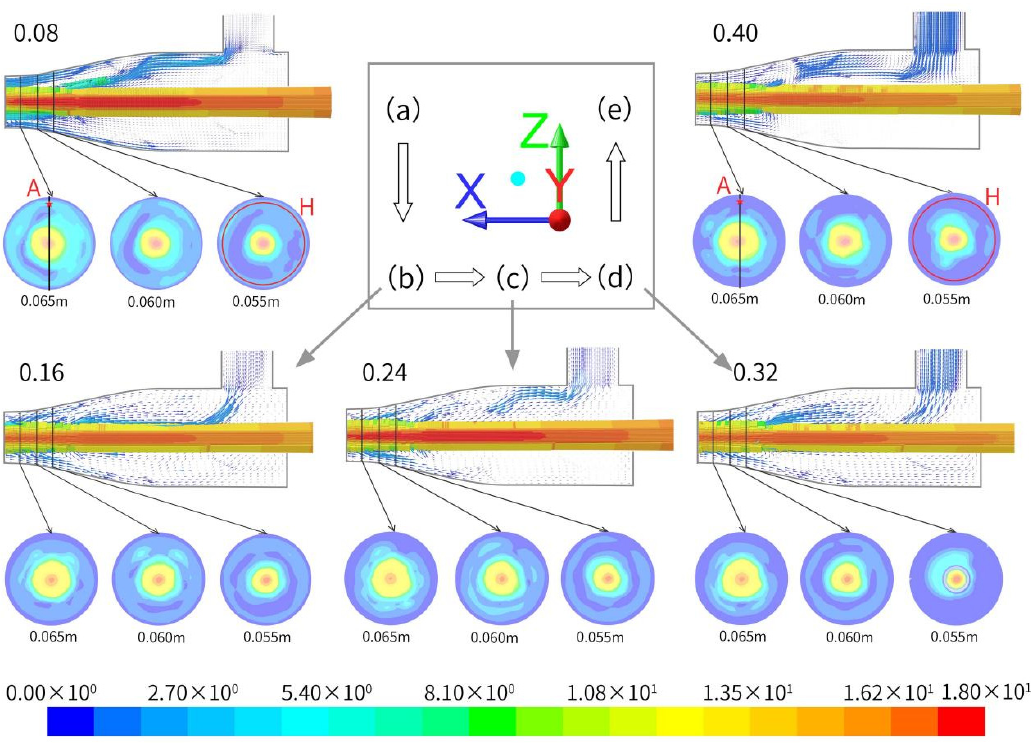
Figure 5. Velocity vector diagram of gas–water mixing zone in nozzle with different air–liquid ra-